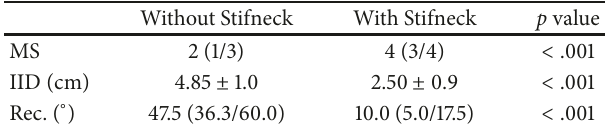
Table 2: Prognostic factors for difficult